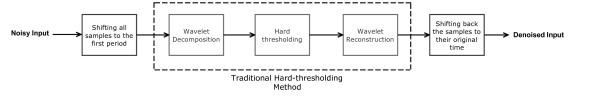
The proposed noise removal steps.